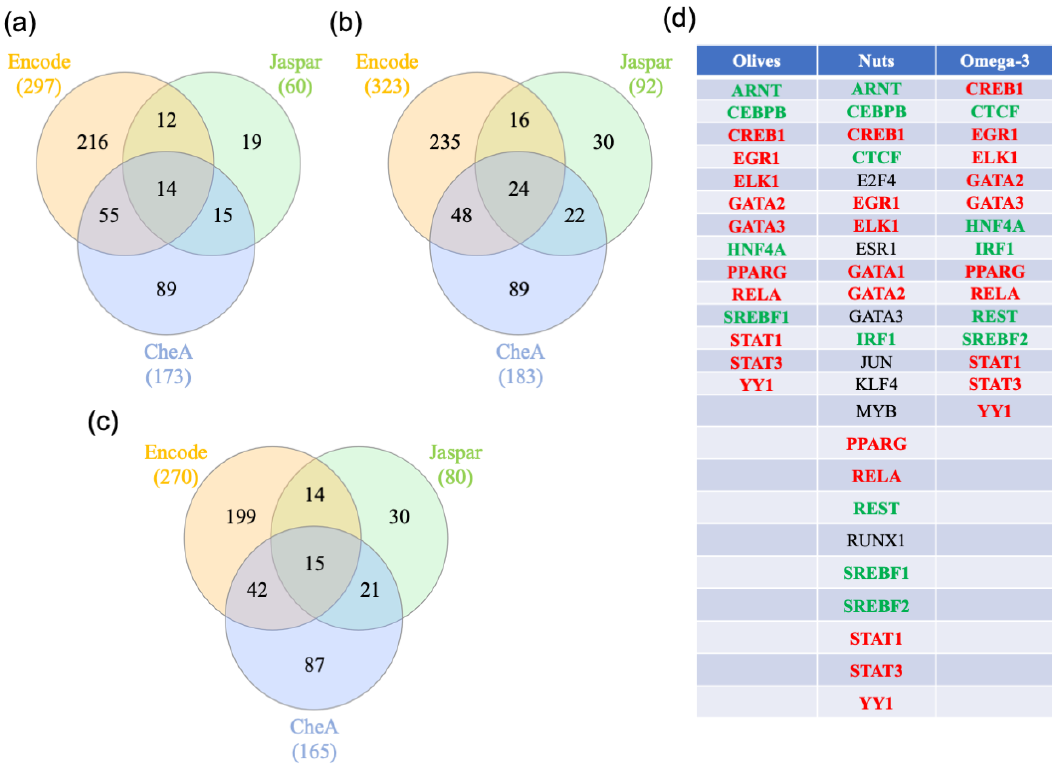
Figure 4. Transcription factor analysis. ( a – c ) Transcription factor analysis for each diet. The gene lists were uploaded to https://www.networkanalyst.ca/NetworkAnalyst/faces/home.xhtml. The gene–transcription factor interaction network was performed with ENCODE, ChEA, and JASPAR, and ( a ), ( b ), and ( c ) represent the results of the Venn analysis performed with olive-, nuts- and omega-3-genes, respectively. The transcription factors interacting with the supplement-regulated genes are listed in ( d ). Transcription factors in red are shared between the three supplements, the transcription factors in green are shared between two supplements, and the transcription factors in black are unique to a supplement.